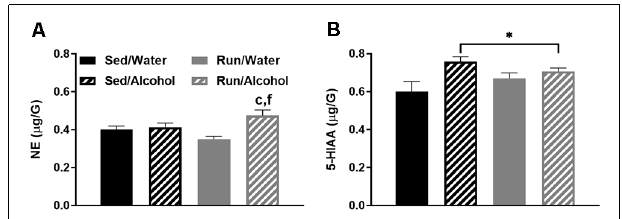
FIGURE 9 | Neurochemical levels in the mouse prefrontal cortex area immediately following the final DID session. NE concentrations (A) , and 5-HIAA concentrations (B) . Data represent means +SEM. ∗ P < 0.05 main effect alcohol access, c P < 0.05 Sed/Water from Run/Alcohol, f P < 0.05 Run/Water from